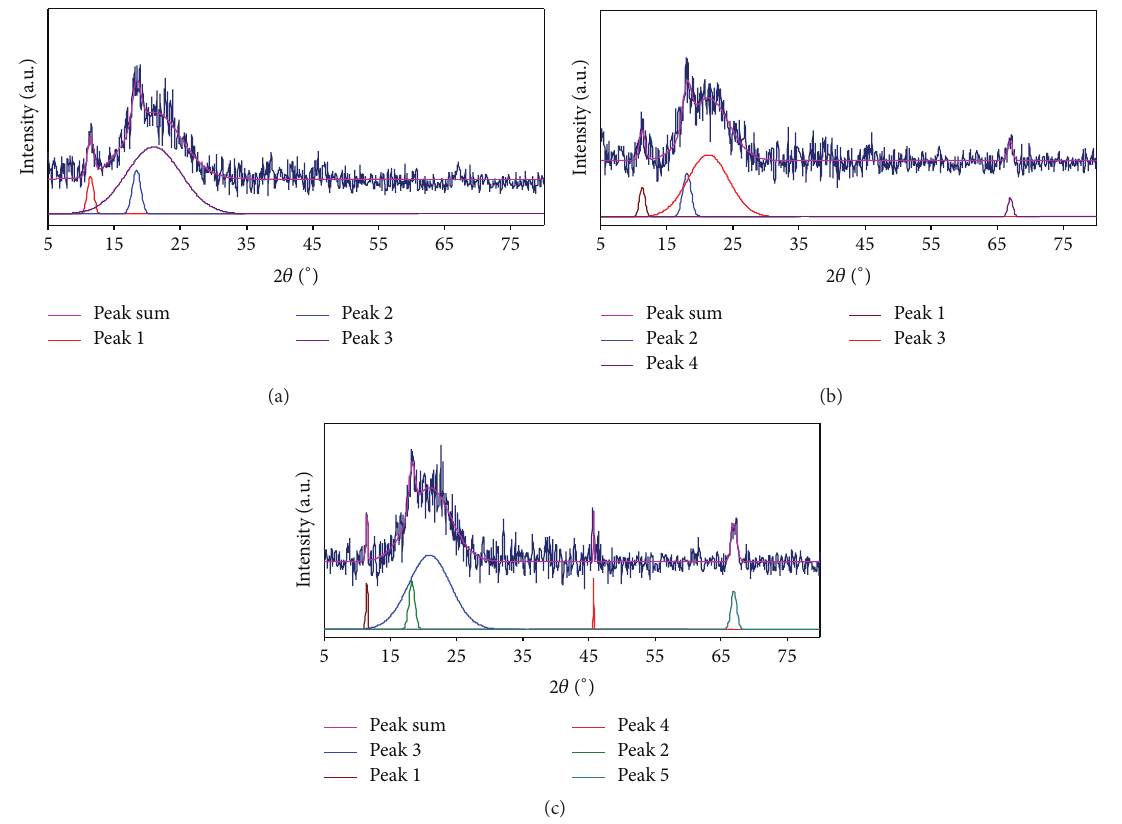
Figure 4: Gaussian fitting of XRD for (a) CSNC2, (b) CSNC3, and (c) CSNC5 samples.